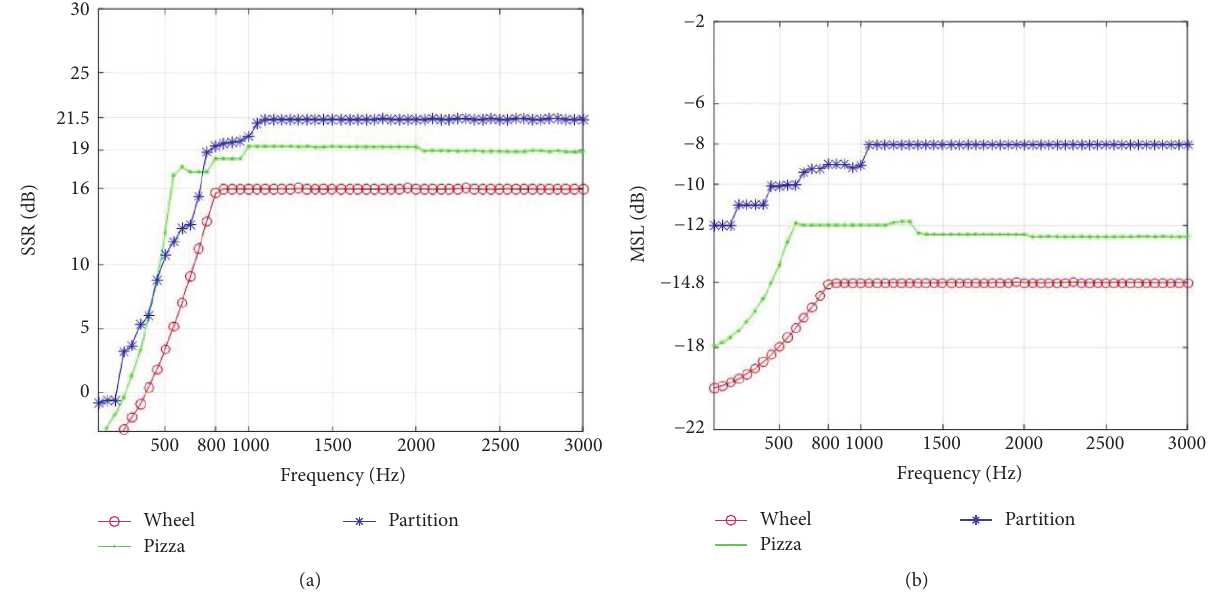
Figure 8: Sidelobe level of three different optimized arrays: (a) sidelobe suppression ratio (SSR); (b) maximum sidelobe level (MSL).